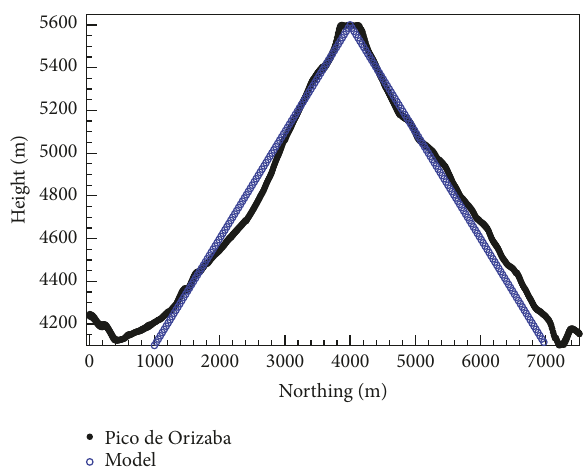
Figure 5: Projection of the Pico de Orizaba profile along the Northing axis. The blue open markers show the profile of the conical approximation to the volcano, while the black closed circles indicate the real profile of the volcano.